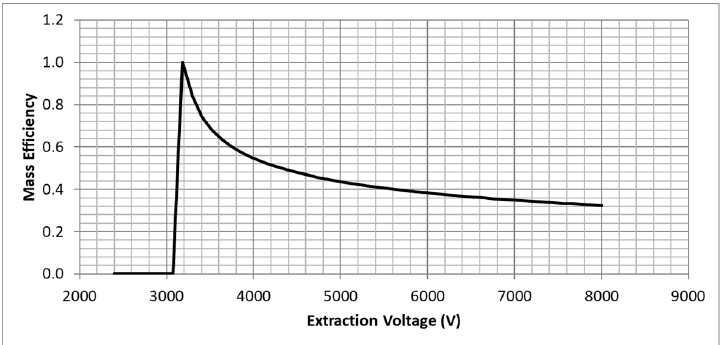
Figure 16. Mass efficiency versus extraction voltage computed by QuickSolver for an indium wetted Figure 16. Mass e ffi ciency versus extraction voltage computed by QuickSolver for an indium wetted emitter tested by Tajmar [14]. emitter tested by Tajmar